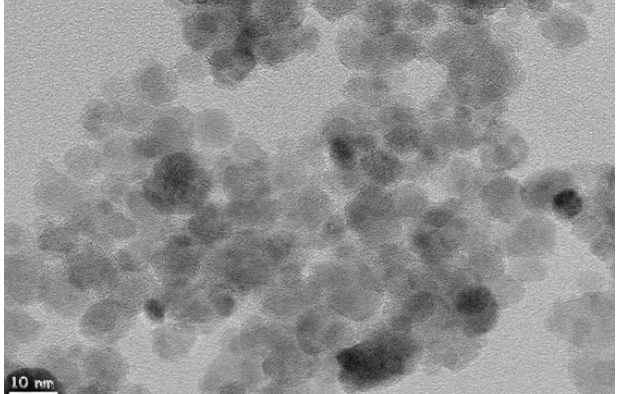
Figure 1. Transmision electron microscopy (TEM) image of magnetic gold